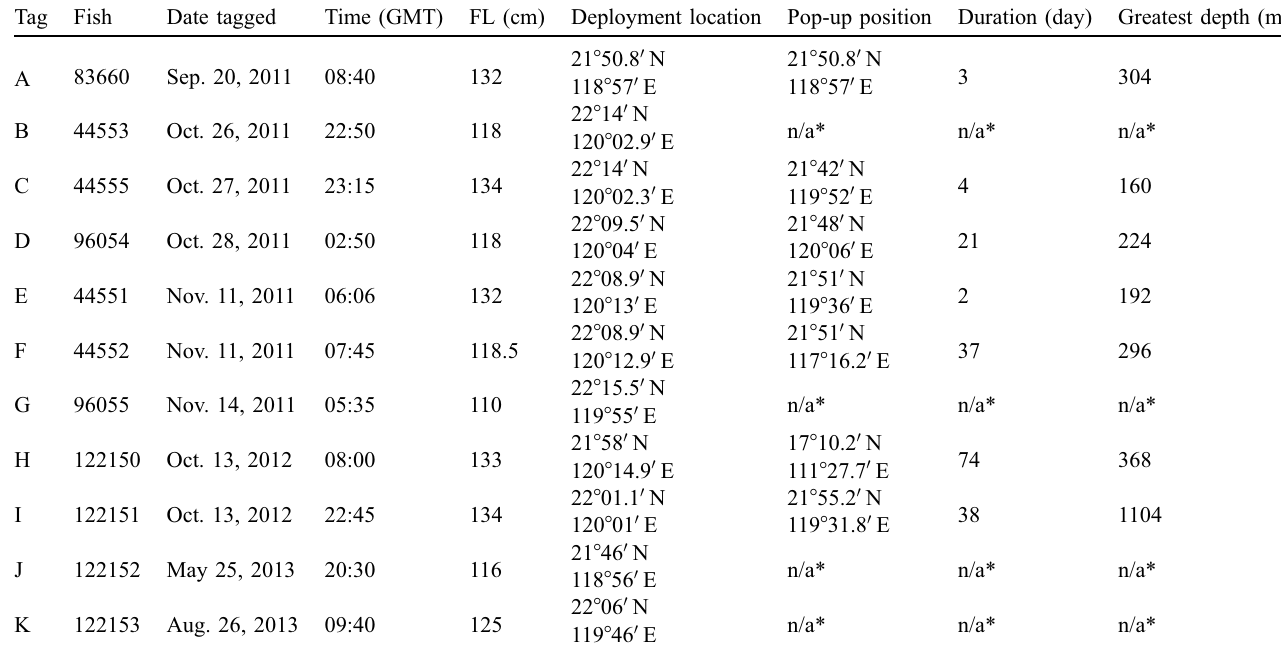
Table 1. Summary of 11 yellow fi n tuna tracked by using pop-up satellite archival tags from 2011 to 2013.